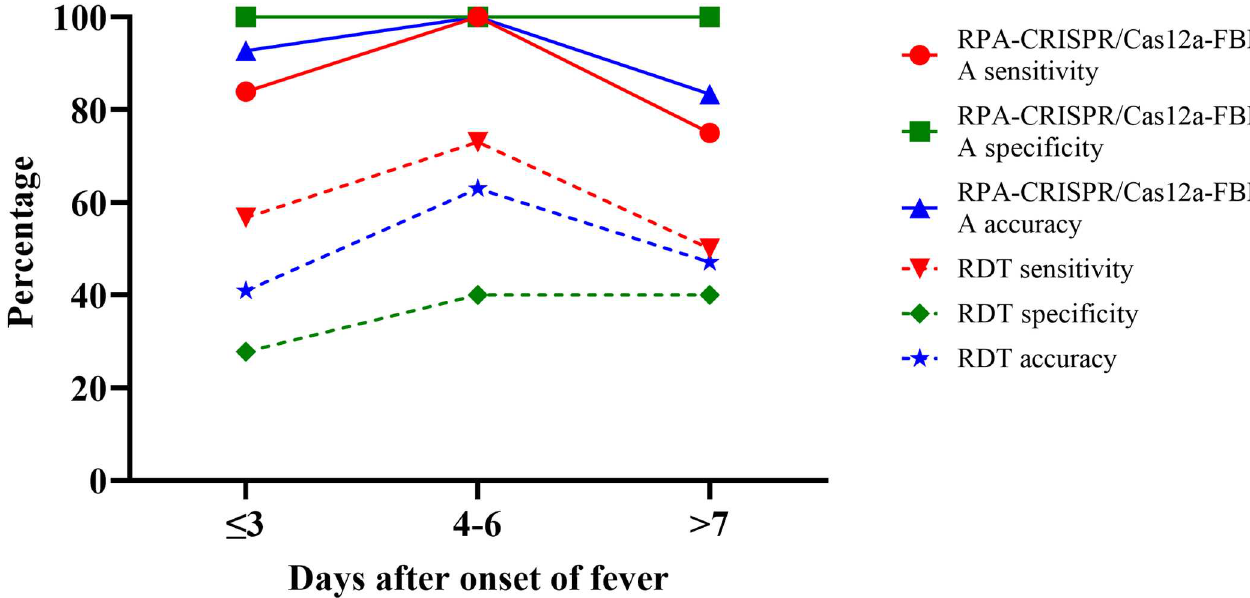
Fig 2. Sensitivity, specificity, and accuracy of the RPA-CRISPR/Cas12a-FBDA (solid line) and RDT (dashed line) at 3 d (red), 4–6 d (green), and � 7 d (blue) after the onset of fever.